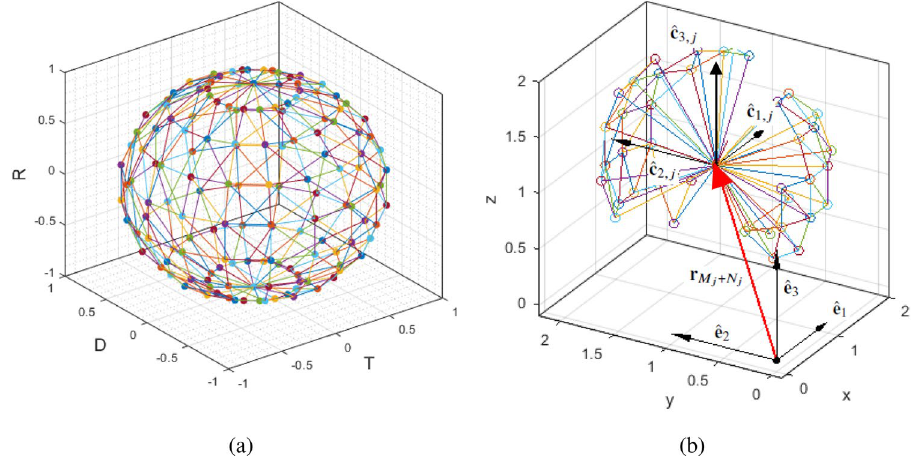
Figure 1. ( a ) T – D – R space polyhedralization for j ∈ C , using the Eqs. (9a) and (9b). The polytopes are contained in a sphere of radius 1 at the initial moment, and conserve their orientation and are deformed and elongated during the pandemic growth. ( b ) The containment polytope 1 ∈ C at day k = 100 . To determine the containment polytope we choose p = 15 and q = 27 , therefore, B 1 = { 1, 2, . . . , N − 1 } and I 1 = { N } .